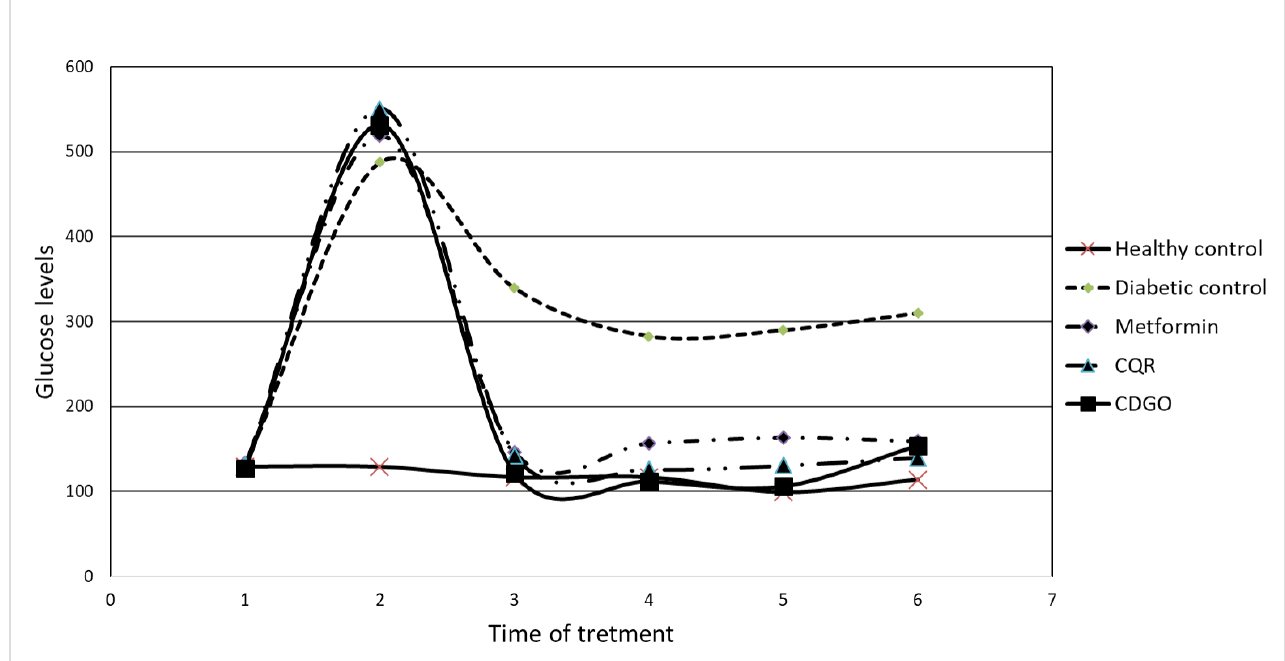
FIGURE 1 - Index of glycemia of the different treatments. 1) Induction to diebates, 2) Start of treatment 48 hours later, 3) Glycemia at one week of treatment, 4) Glycemia at 20 days of treatment, 5) Glycemia at 30 days of treatment, 6) Glycemia at 7 weeks of